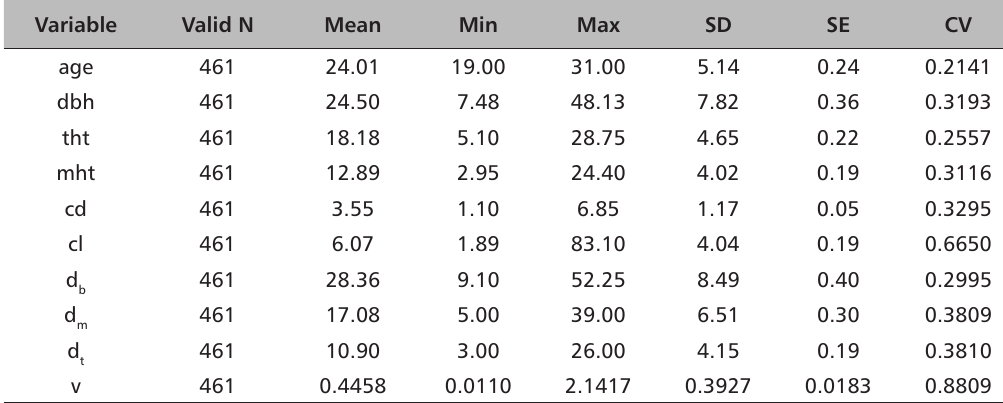
TABLE 1. Summary statistics of the measured and derived variables of Pine at individual tree